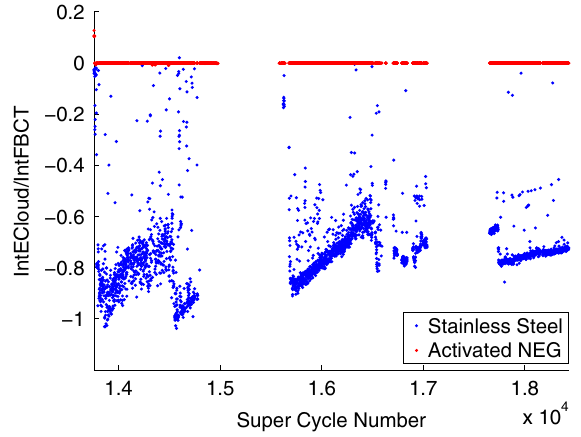
FIG. 4. ECM signals from StSt and NEG liners during the SPS scrubbing run with supercycle length of 43.2 s: integrated electron current signal (negative values) for each supercycle divided by integrated FBCT signal for each supercycle [ nC = 10 10 protons per bunch] as a function of supercycle